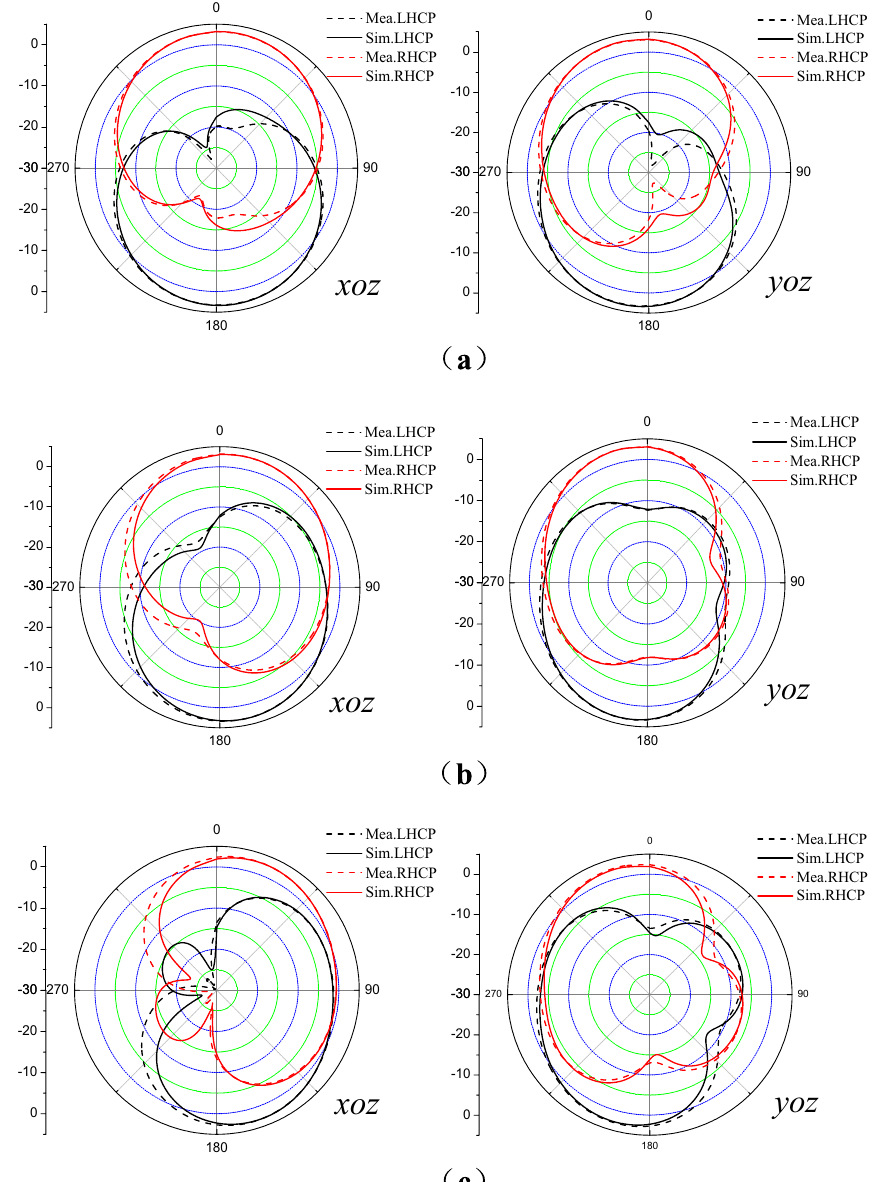
Fig. 13 RHCP & LHCP radiation patterns measured in the xoz and yoz planes. a 6.3 GHz. b 7.5 GHz. c 8.5 GHz. The simulation results are also included for the